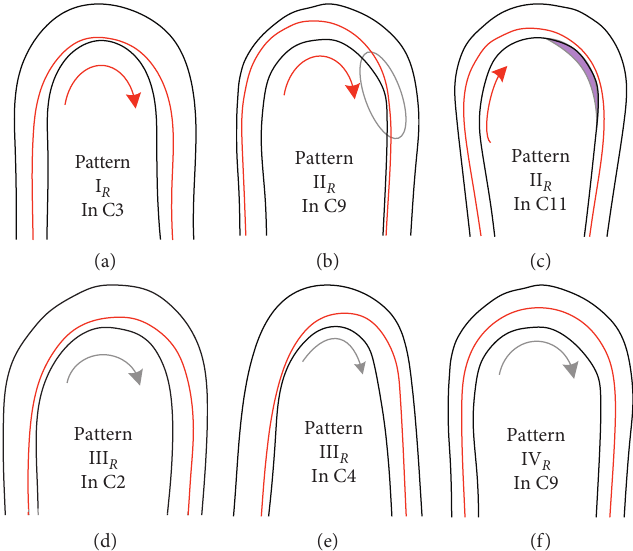
Figure 9: Right-turning track patterns at the hairpin curves. (a) Pattern I R : curve-cutting in curve middle; (b) and (c) pattern II R : cutting the curve when departing; (d) and (e) pattern III R : cutting the curve at the entrance; (f) pattern IV R : traveling in the middle of the road.